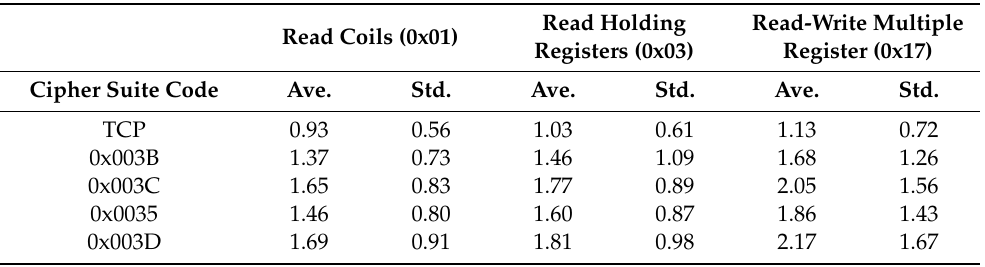
Table 6. Average latencies (ms) and standard deviation in Cipher Block Chaining (CBC) cipher mode (without RBAC